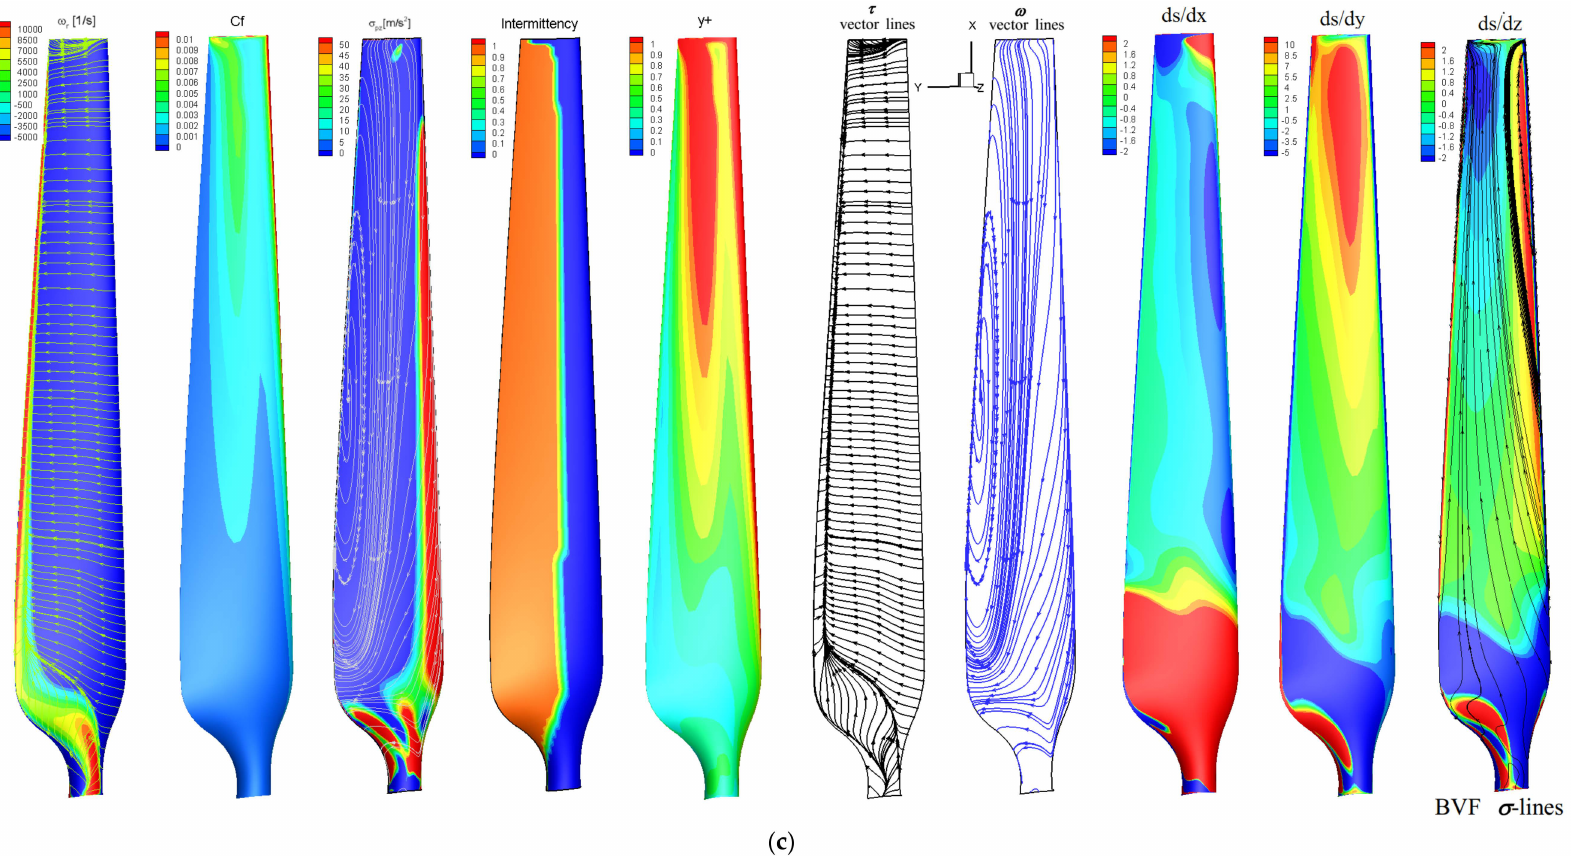
Figure 31. ( a ) Properties plotted on the suction side using vorticity dynamics for WTdesign1 with S809 airfoil. ( b ) Properties plotted on the suction side using vorticity dynamics for WTdesign2 with s809 airfoil. ( c ) Properties plotted on the suction side using vorticity dynamics for WTdesign3 with NACA2420